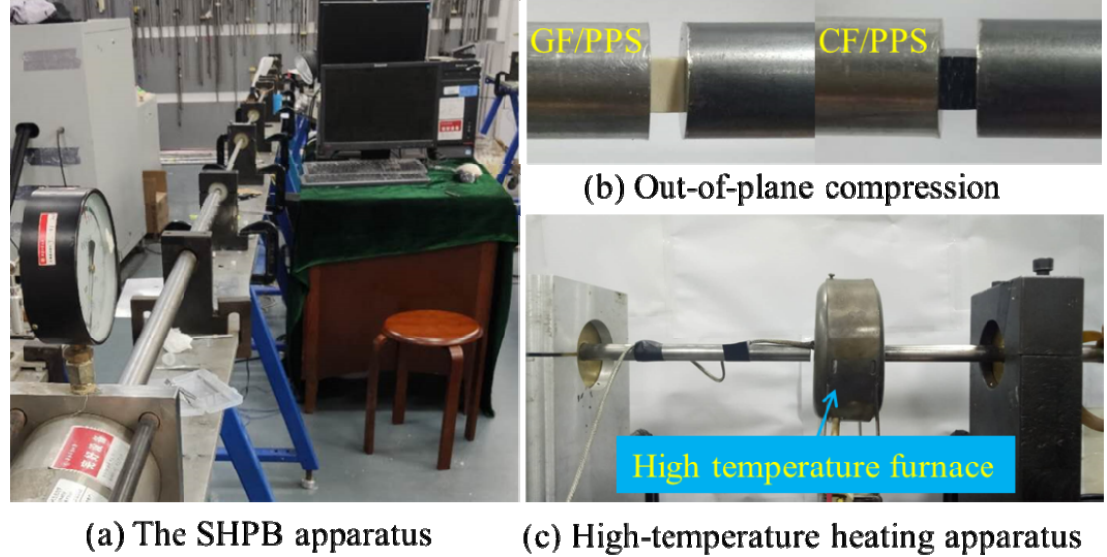
Figure 2. Experiment equipment and specimen assemblage scheme. ( a ) The SHPB apparatus; ( b ) Out-of-plane compression; ( c ) High-temperature heating apparatus.